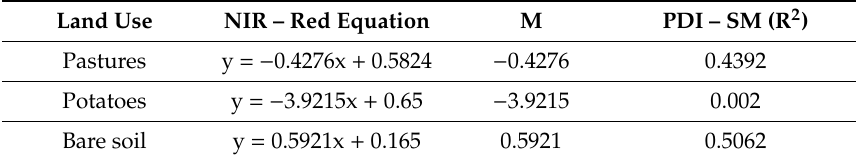
Table 2. NIR–red linear equations to obtain the M value to calculate the PDI at 4 cm.